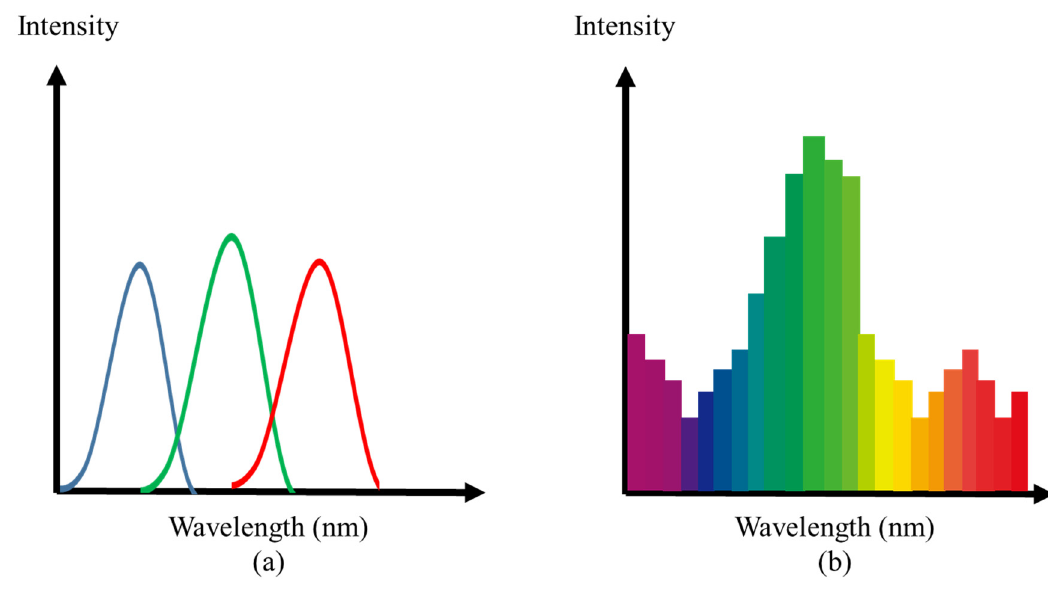
ff erence between ( a ) an RGB image and ( b ) hyperspectral Figure 9. The difference between ( a ) an RGB image and ( b ) hyperspectral imaging. Figure 9. The di